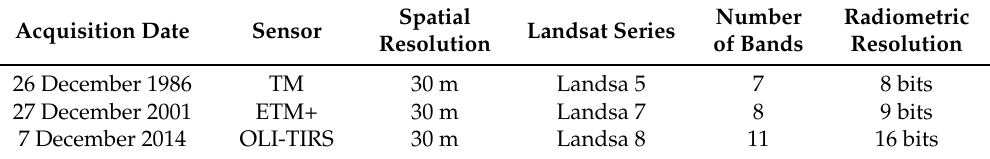
Table 2. Satellite Image